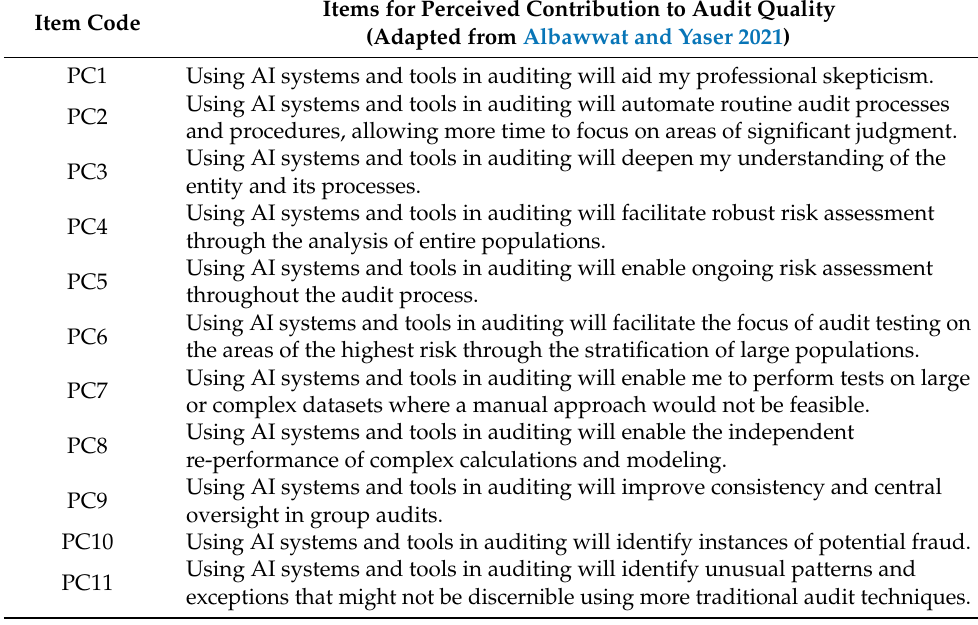
Table 1. Items for perceived contribution to audit quality. Item